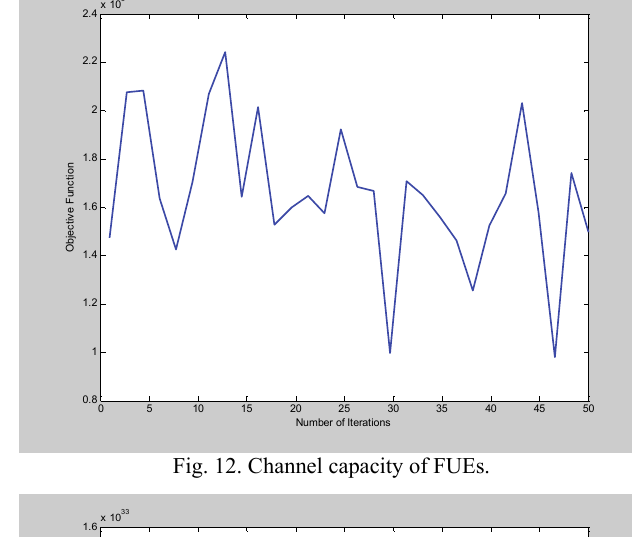
Fig. 12. Channel capacity of FUEs.